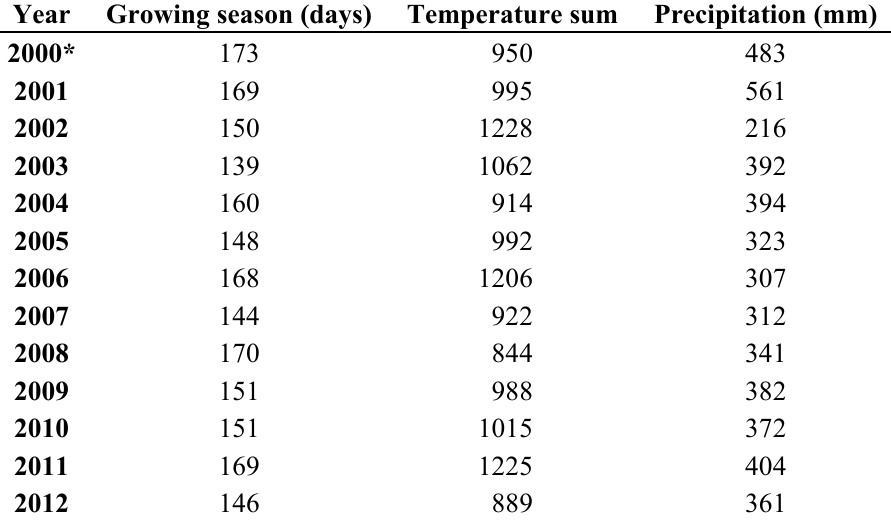
Table 1. Local climatic data during the growing season of the 13-year study period. The year denoted with an asterisk corresponds to the year of